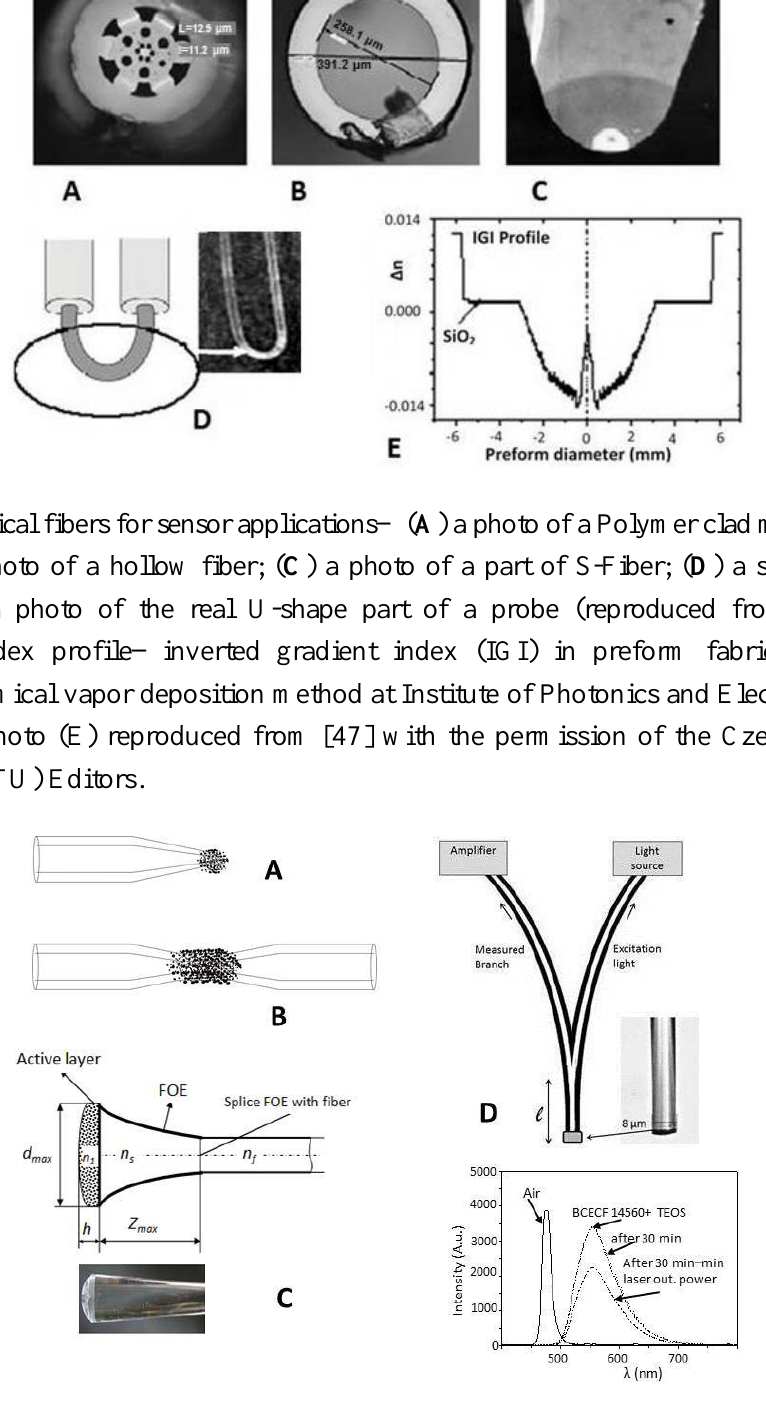
Figure 2. Tapered fiber ( A ) One conus with active layer on a tip; ( B ) Two conus with active layer; ( C ) Tapered up fiber optic element (FOE) with active layer and a photo of FOE with microorganisms immobilized in silica gel; ( D ) Schema of V-taper with a photo of a real tip V-taper and a graph of the dependence of measured fluorescence on the wavelength in the measure branch of V-taper. Strength line—without active layer (no fluorescence) and dash line—with active layer on the tip for two different output powers of laser and time after coating of